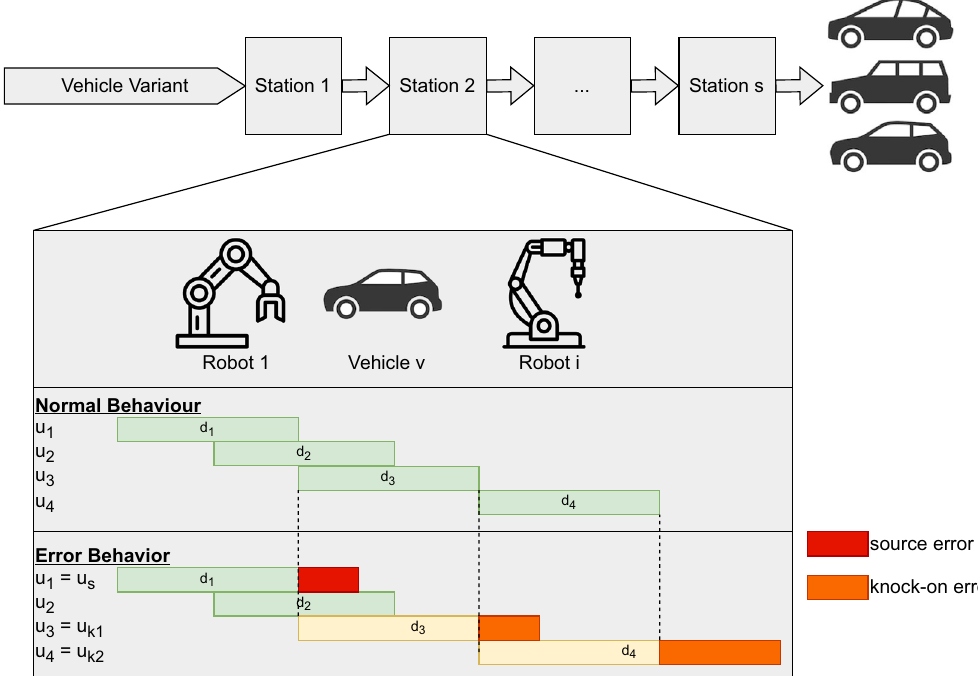
Figure 1. Production line for assembling vehicle variants, illustrating normal behaviour and error behavior in a Gantt-chart, with respect to durations d . Several actions can happen in parallel. In the error behavior scenario a source error for an action duration tuple u s (marked red) can lead to multiple knock-on error u k 1 and u k 2 (marked